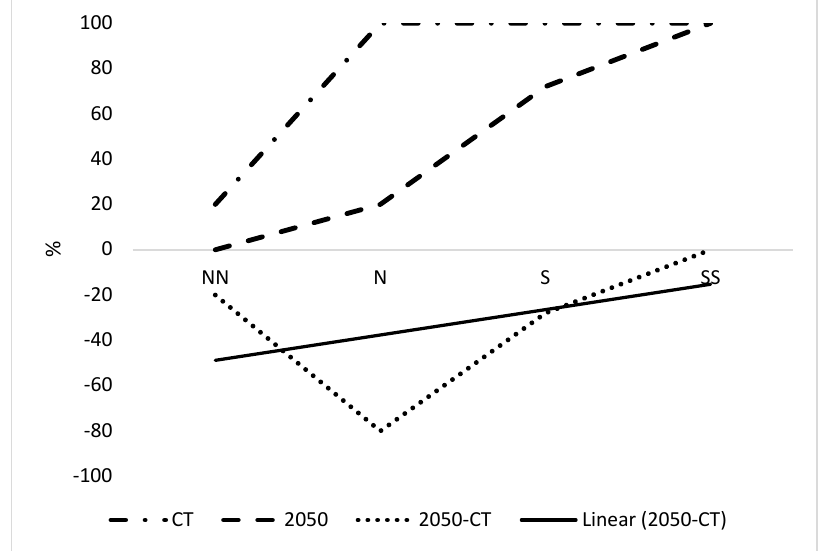
Figure 5. Latitudinal trend in CSC for the east zone of Nigeria. NN, N, S and SS represent north-north, north, south and south-south, respectively, of Nigeria. CT is current time.